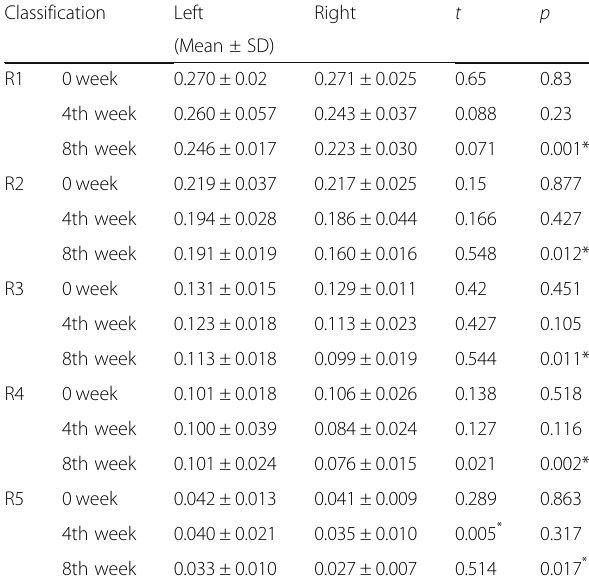
Table 7 The change of skin roughness